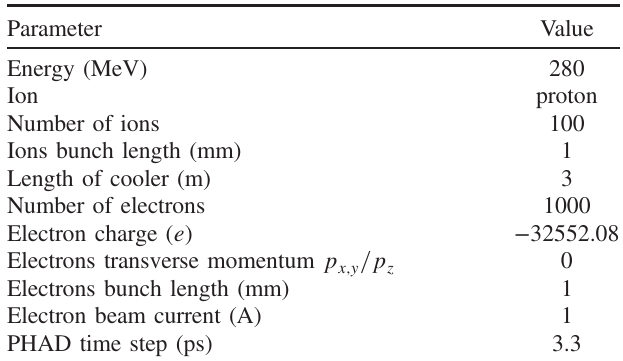
TABLE II. Initial parameters of the simulations of electron cooling of the proton beam.